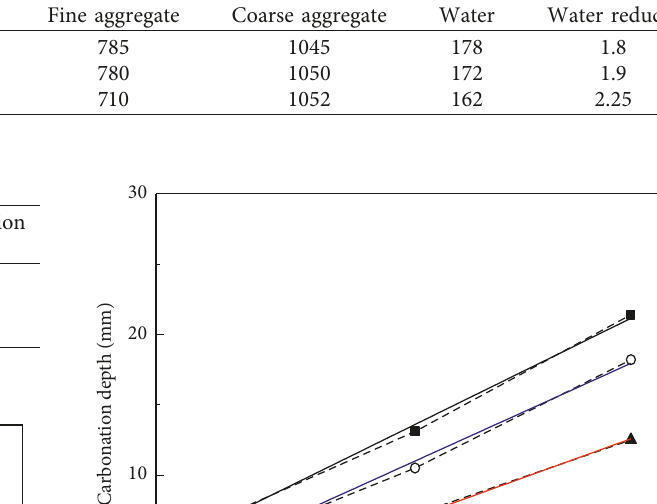
Table 1: Mix proportion of concrete (kg · m − 3 ).